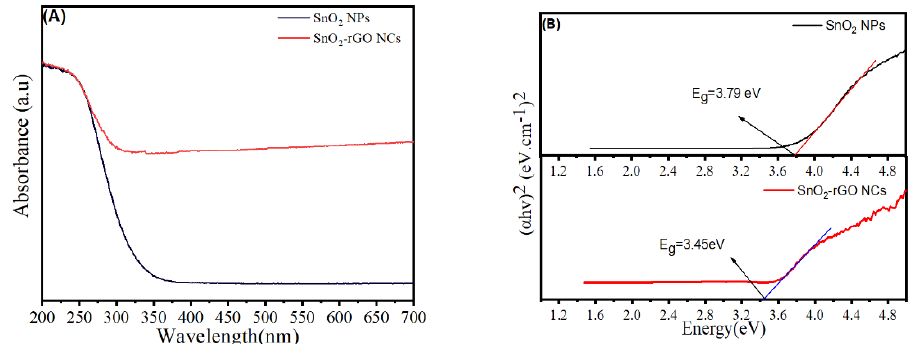
Figure 8. UV–Vis spectra of the SnO 2 NPs and SnO 2 -rGO NCs ( A ); the bandgap energy of the SnO 2 NPs and SnO 2 -rGO NCs ( B ).